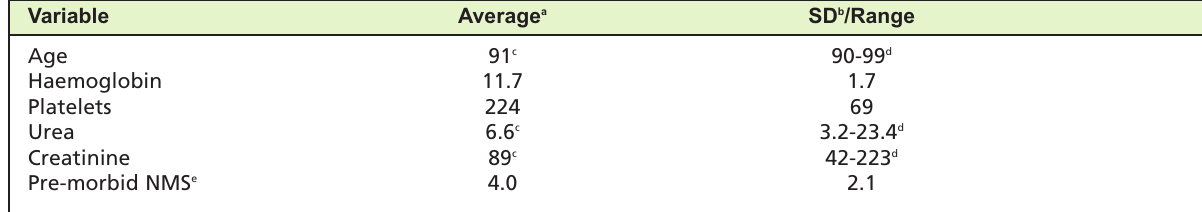
Descriptive statistics for continuous Table II: